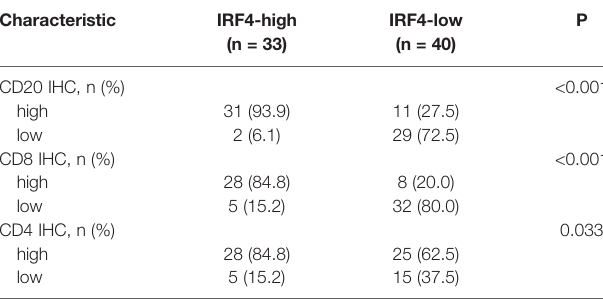
TABLE 4 | The correlation analysis between IRF4 and immune cells in fi ltration in lung adenocarcinoma patients.